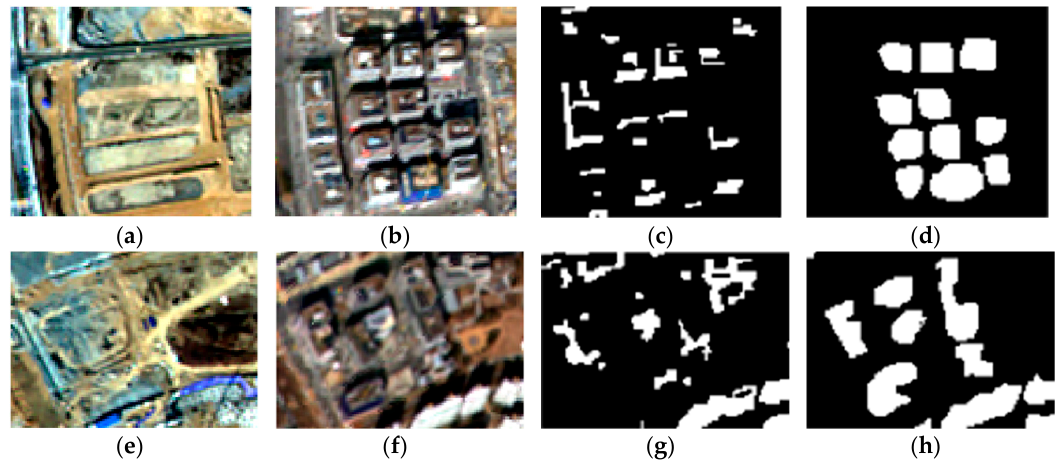
Figure 11. Examples of missed detection cases in experiment 1 ( a – d ) and experiment 2 ( e – h ): ( a ) image T1 of the first subset, ( b ) image T2 of the first subset, ( c ) the result of the first subset by the proposed method, ( d ) the reference map of the first subset, ( e ) image T1 of the second subset, ( f ) image T2 of the second subset, ( g ) the result of the second subset by the proposed method, and ( h ) the reference map of the second subset.